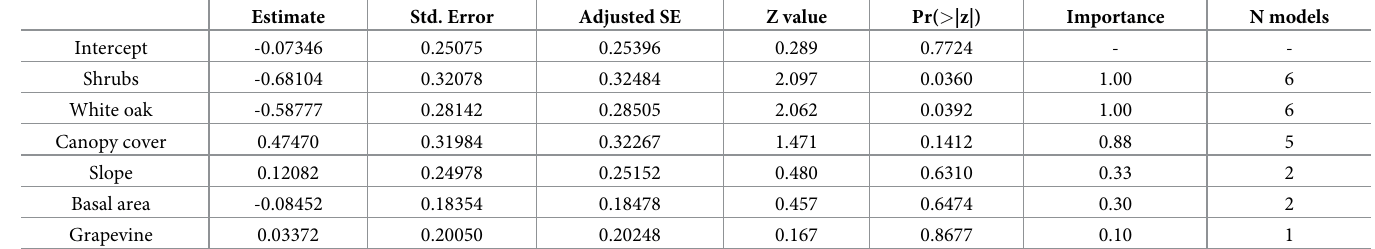
Table 4. Model-averaged coefficients of Cerulean Warbler roost sites. Model-averaged coefficients (full average) for Cerulean Warbler ( Setophaga cerulea , Wilson) roosts compared with random points in southern Indiana, May-June 2017 with model-averaged coefficients (full average). Estimate Std. Error